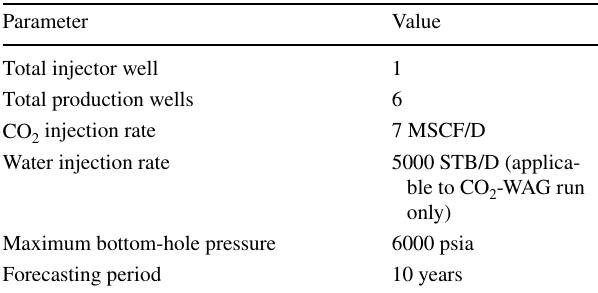
Table 9 Constraints used to run CCO modeling